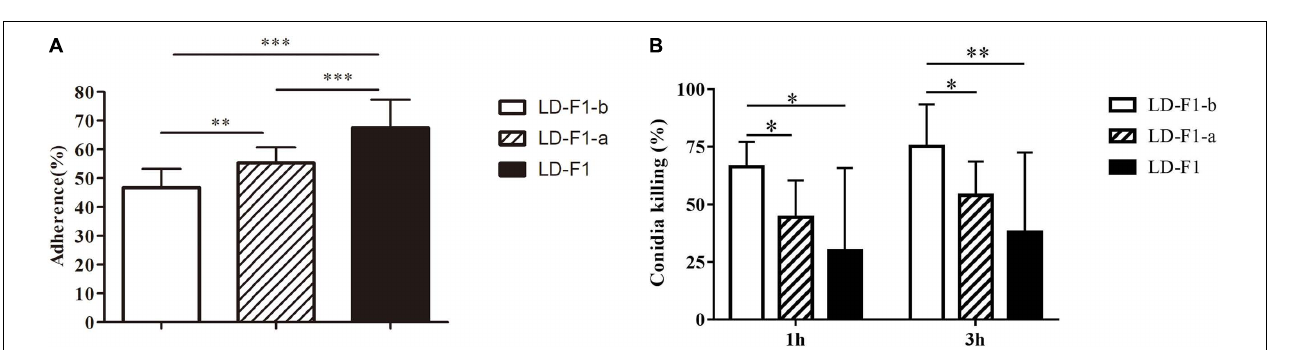
FIGURE 9 | (A) Adherence of conidia of virus-free isolate (LD-F1), AfPV1-infected isolate (LD-F1-b), and AfPV1- and SatRNA-infected isolate (LD-F1-a) to A549 human pneumocyte cells. (B) Conidial killing of virus-free isolate (LD-F1), AfPV1-infected isolate (LD-F1-b), and AfPV1- and SatRNA-infected isolate (LD-F1-a) to at 1 and 3 h phagocytosis by RAW264.7, a murine macrophage cell line. P -values were estimated using Tukey’s multiple comparisons, non-parametric Kruskal–Wallis and Dunn’s multiple comparison tests. * P < 0.05, ** P < 0.01, *** P <